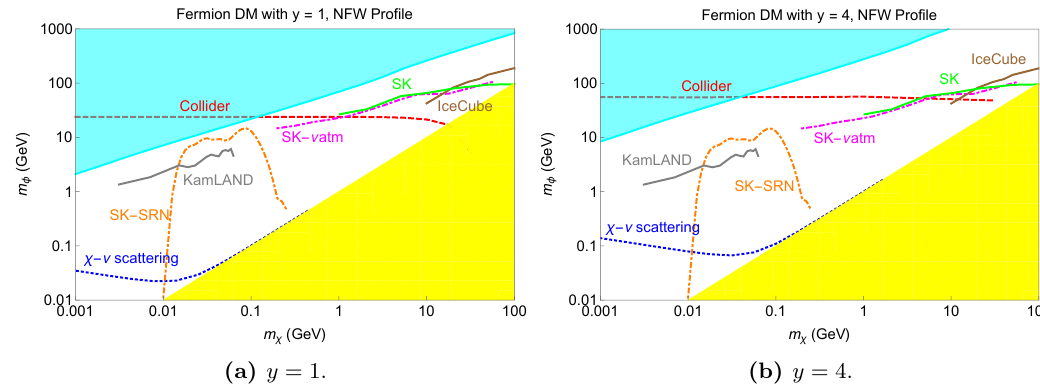
Figure 11. The 90% CL bounds from various neutrino telescope observations compared with the collider bounds in the m (cid:31) - m (cid:30) plane. The gray line, labelled KamLAND, is the (rescaled) o(cid:14)cial KamLAND bound [69]. The green line, labelled SK, is the o(cid:14)cial SK bound [68]. The brown line, labelled IceCube, is the o(cid:14)cial IceCube bound [67]. The orange, dot-dashed line, labelled SK-SRN, is the bound obtained from recasting the SK SRN searches discussed in section 4.1. The magenta, dot-dashed line, labelled SK- (cid:23) atm, is the bound obtained from recasting the SK atmospheric neu- trino measurements discussed in section 4.2. The blue dotted lines are the cosmological bounds from the DM-neutrino scattering discussed in section 2.2. The dashed lines are the bounds obtained by taking the strongest bounds between the LHC mono-lepton and the invisible Z decay width. All the regions below the lines are excluded by the respective observations/experiments. The shaded cyan region is the region that gives (cid:10) (cid:31) h 2 > 0 : 1186 as simulated by Micromegas 5.0 [80]. The shaded yellow region is the region which m (cid:31) > m (cid:30) . In these plots, the dark matter pro(cid:12)le is taken to be the NFW